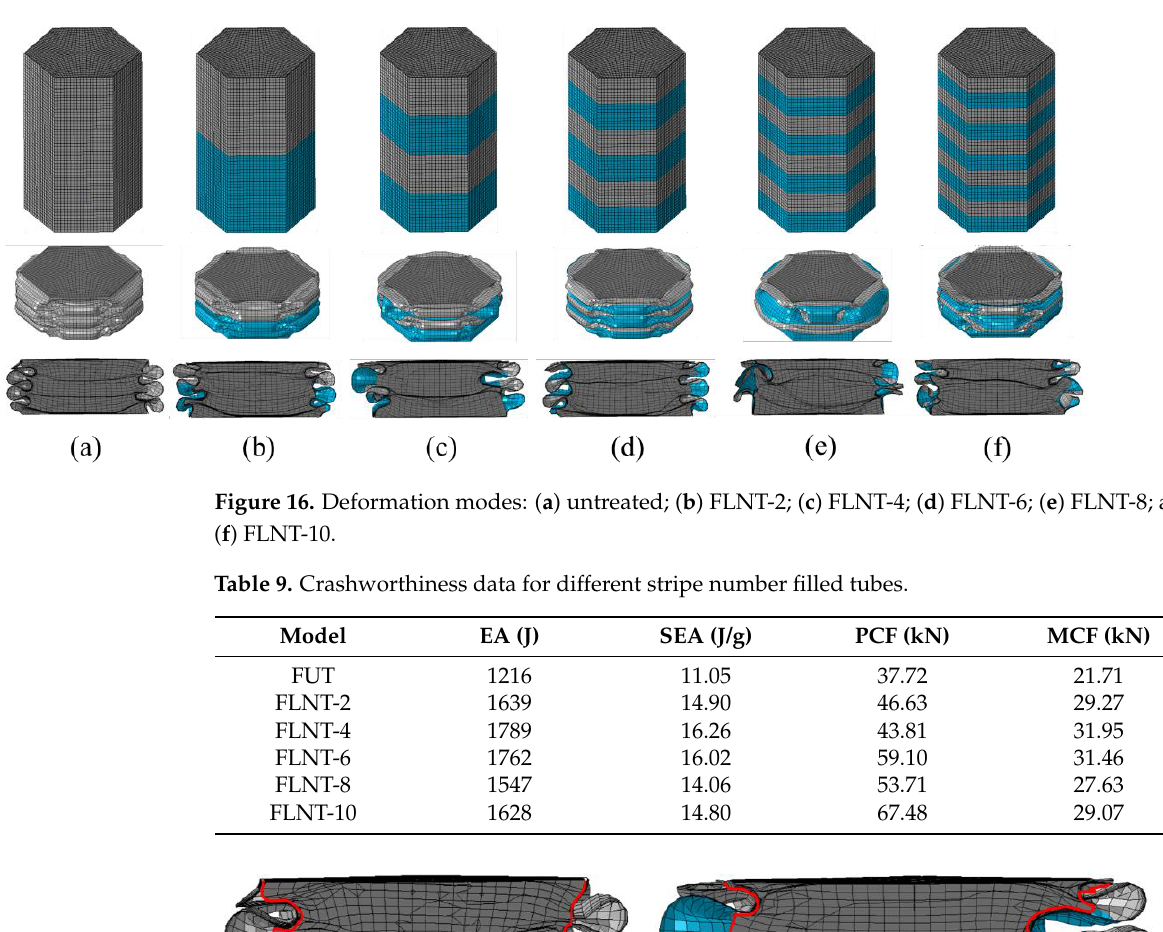
Figure 15. Effect of stripe number for filled tubes: ( a ) load – displacement relations and ( b ) energy – displacement relations.